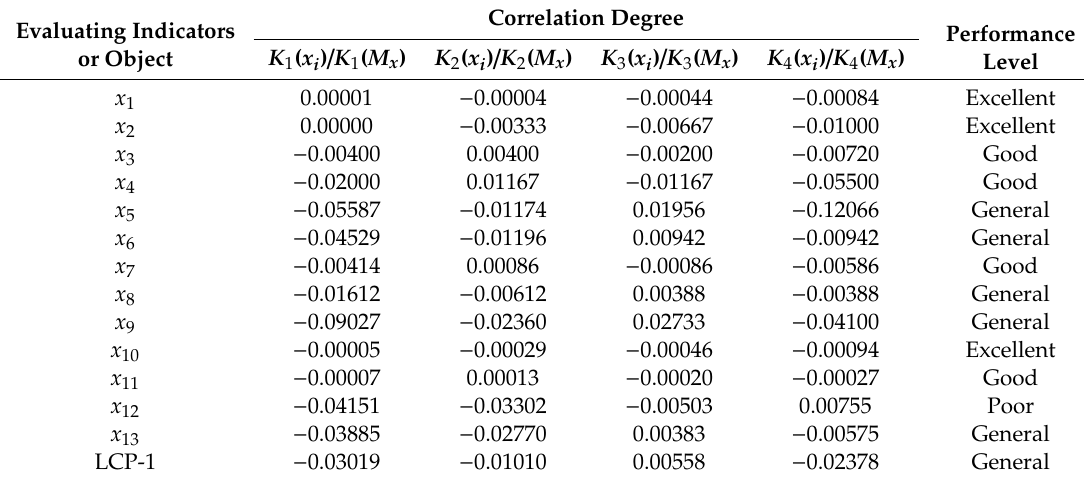
Table 4. Results of performance evaluation of